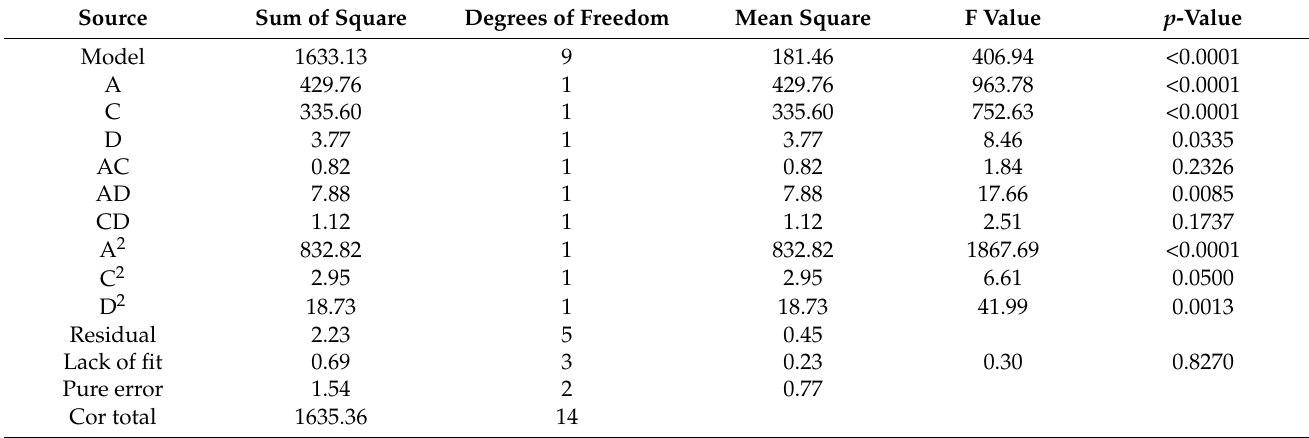
Table 7. Analysis of variance for response surface quadratic